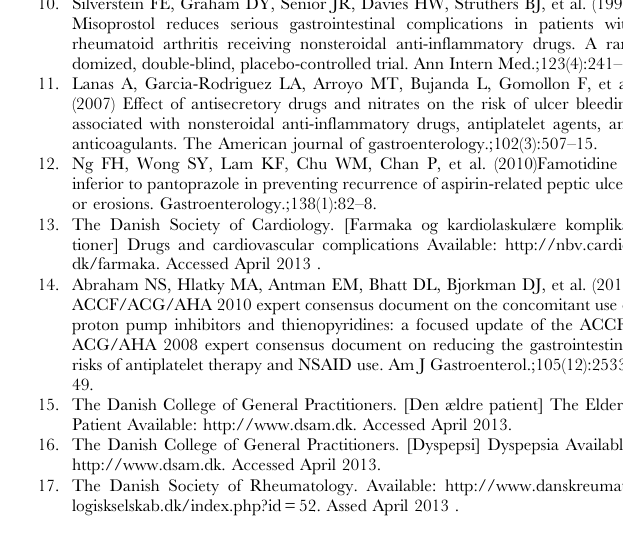
The following continuation of these treatment strategies in primary care is indicated by arrows.